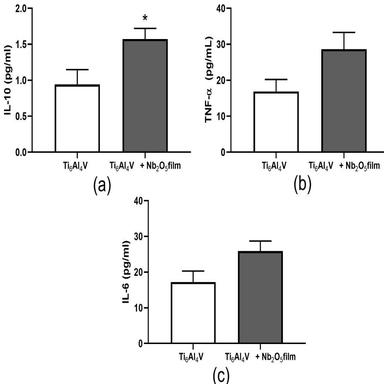
Effect of coated and uncoated biomaterial in cytokine production of Human blood leucocytes cells. (a) IL-10, (b) TNF-α and (c) IL-6. Bars represent the mean ± standard error production level of the cytokines from quintuplicate samples. P ≤ 0.05 compared with uncoated Ti6Al4V alloy.